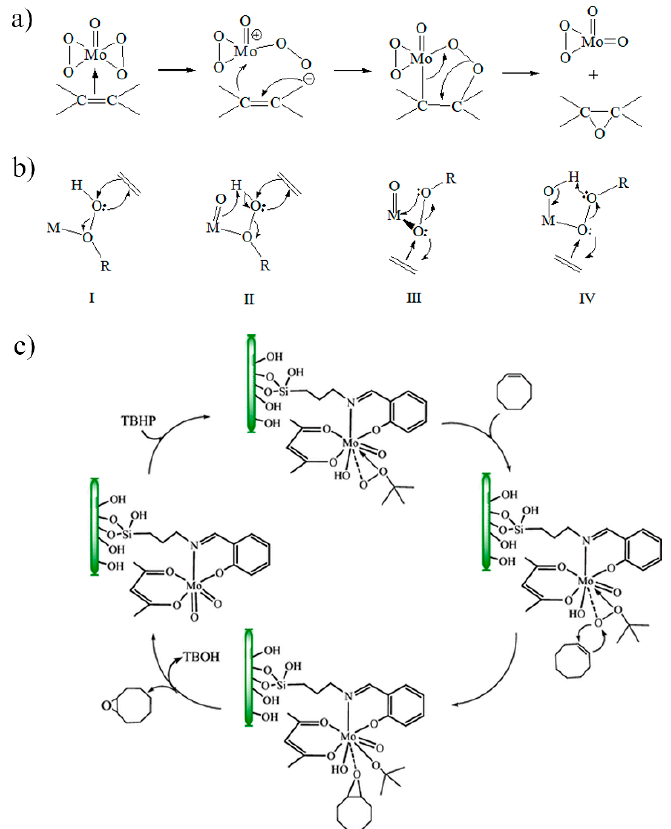
Figure 8. ( a ) Mechanism for epoxidation of alkenes proposed by Mimoun et al. Reproduced with permission from reference [107]. Pergamon (1970); ( b ) Epoxidation mechanisms involving coordinated alkyl hydroperoxide. Reproduced with permission from reference [17]. ACS Publications (1977); ( c ) Proposed mechanism for alkenes epoxidation with TBHP using molybdenum-based catalysts. Reproduced with permission from reference [93]. Springer (2018).